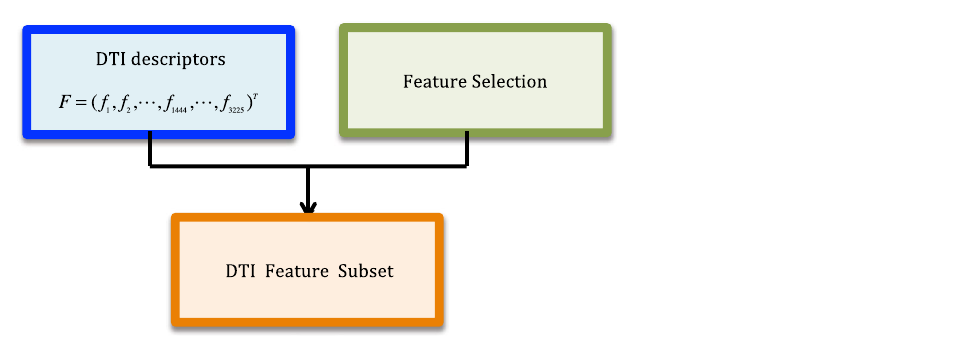
Figure 1. Representing each DTI as a vector.